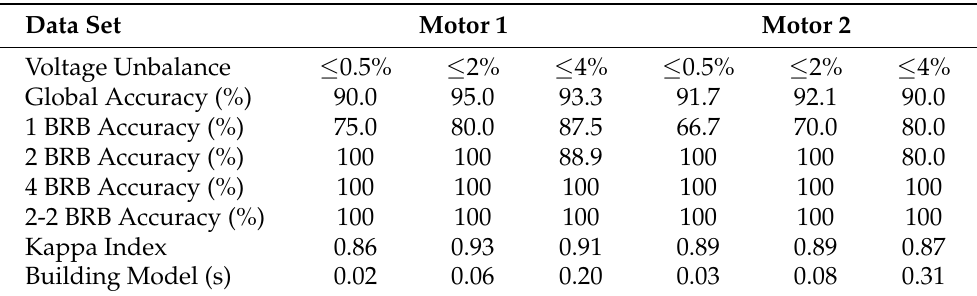
Table 11. Experimental results using PCA for reduce the SMI attributes—Severity analysis of rotor